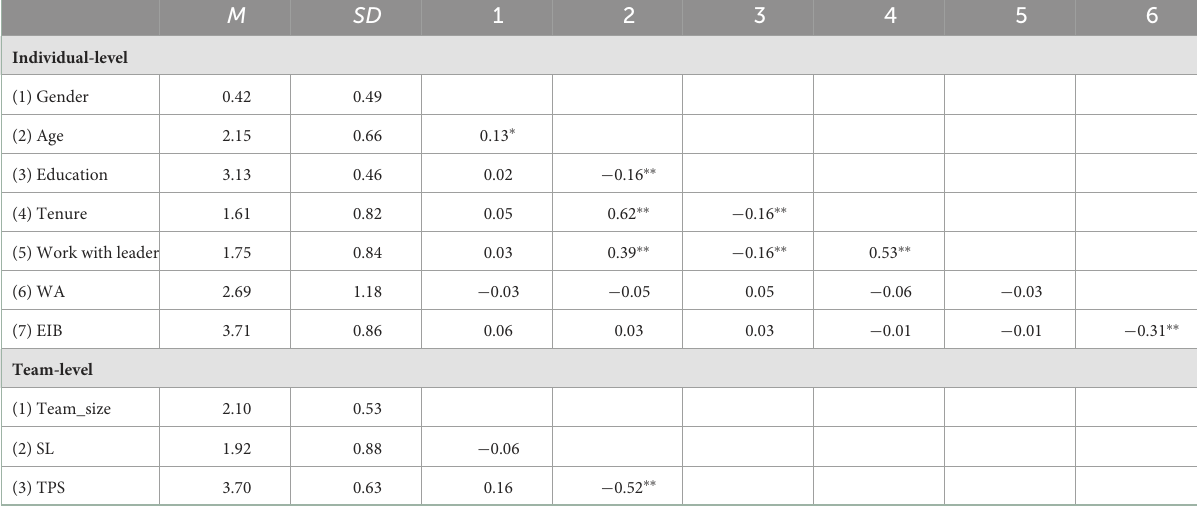
TABLE 3 Means, standard deviations, and correlations.